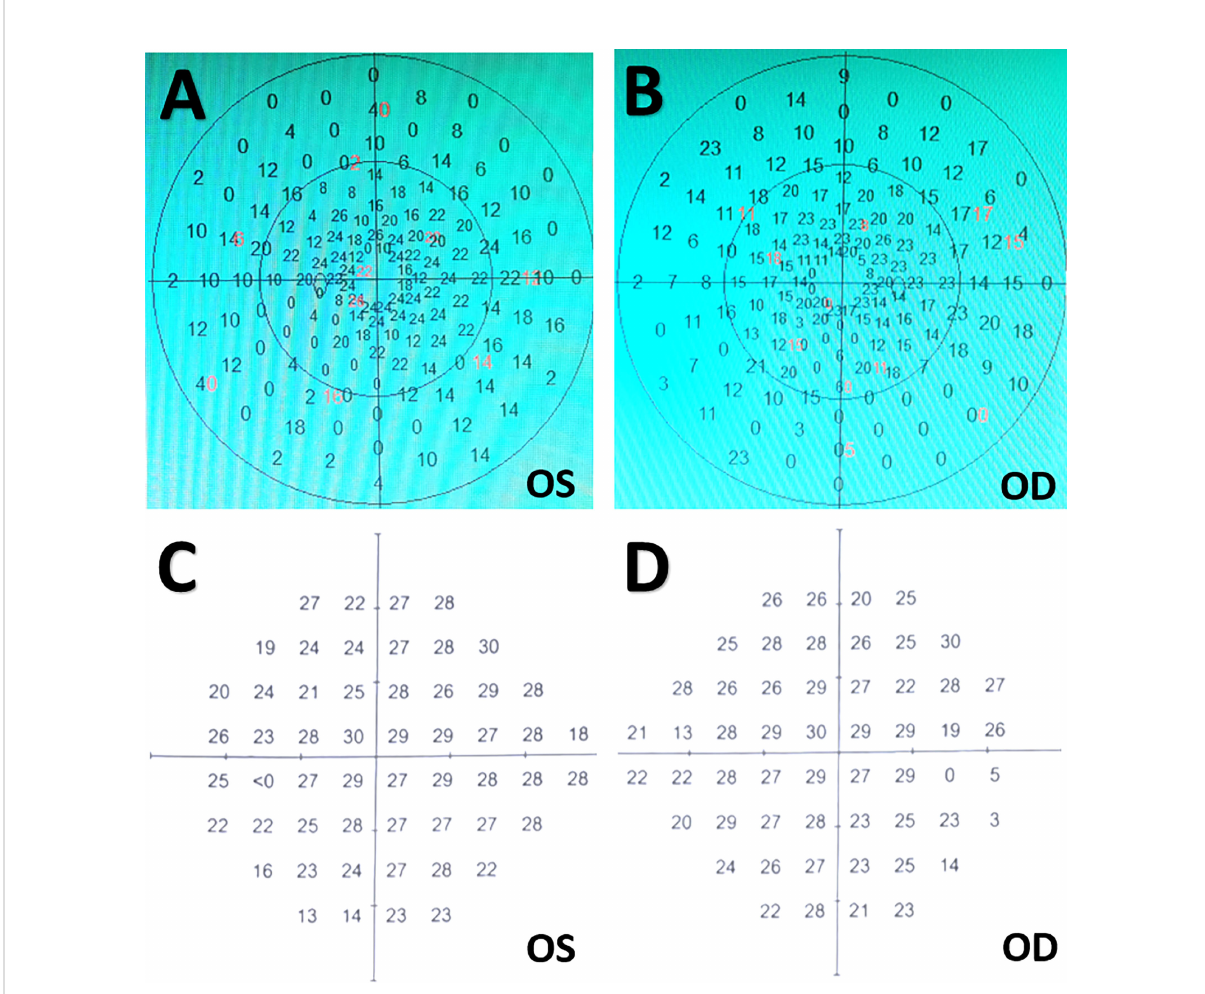
FIGURE 1 Visual fi eld tests before and after surgery. (A, B) Preoperative ophthalmologic examinations indicating bilateral tunnel visual fi elds. (C, D) Postoperative visual fi eld tests three months after surgery showing slight peripheral visual fi eld loss in bilateral eyes. OD, oculus dexter; OS, oculus